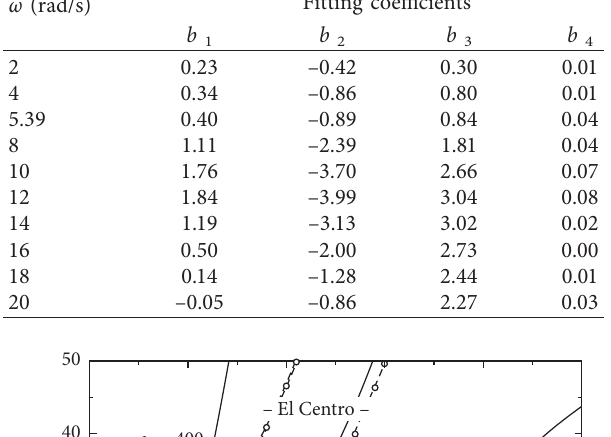
of the original frame.